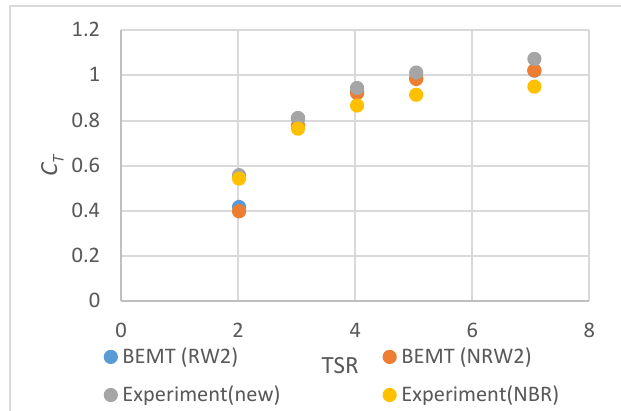
Figure 22. C T comparison between modified BEMT calculations and modified experimental data under wave-current interactions with a wave height of approximately 0.09m and an apparent wave period of